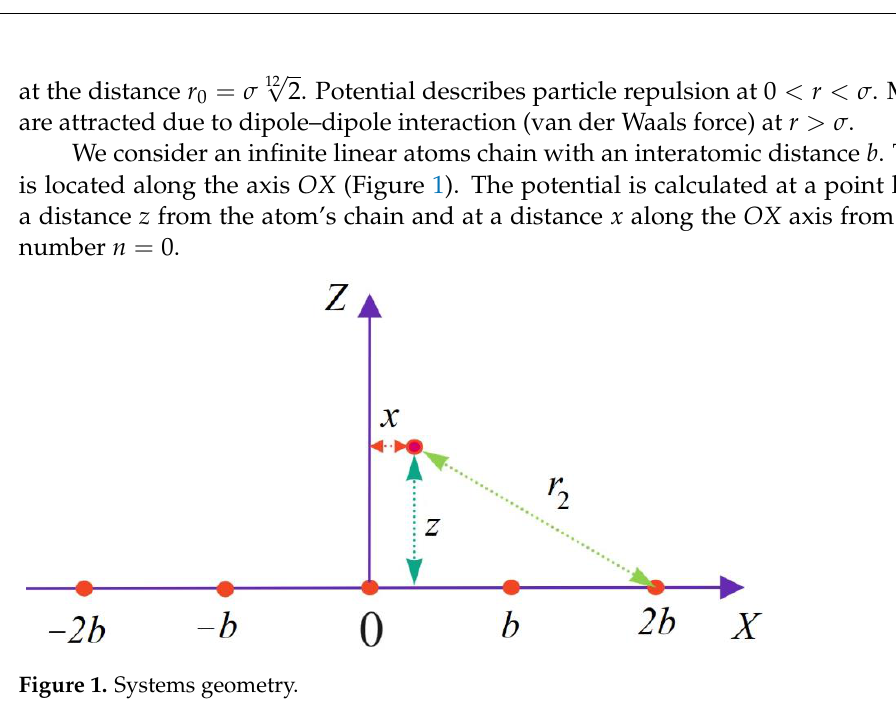
Figure 1. Systems geometry.